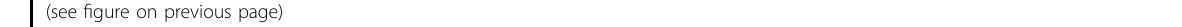
Fig. 6 Characterization of TAMs in ccRCC. a , b Subclustering of TAMs on the UMAP plots of the scRNA-seq and scATAC-seq datasets. c Dot plot showing the expression levels and activity scores for known phenotypic markers in each TAM cluster. Dot size indicates the fraction of expressing cells, colored based on normalized expression or activity. d Heatmap showing the expression of MHC molecules, chemokines, cytokines, and other related genes in each TAM cluster. e Boxplots showing the M1 and M2 signature scores for each TAM cluster in the scRNA-seq data. The signature score was calculated by the VISION method. Two-sided Wilcoxon test. ns, no signi fi cance; * P < 0.05; ** P < 0.01; *** P < 0.001; **** P < 0.0001. f , g Boxplot showing the angiogenesis and phagocytosis signature scores for each TAM cluster in the scRNA-seq data. The signature score was calculated by the VISION method. Two-sided Wilcoxon test. ns, no signi fi cance; * P < 0.05; ** P < 0.01; *** P < 0.001; **** P < 0.0001. h Dot plot showing the expression of the immune costimulatory, checkpoint, and evasion genes for each TAM cluster in the scRNA-seq dataset. i Heatmap of log 2 (FC) values for TFs with signi fi cant differences both in the scRNA-seq and scATAC-seq datasets. j TF regulatory network showing the predicted target genes for MEF2C in the TAM-C1QB